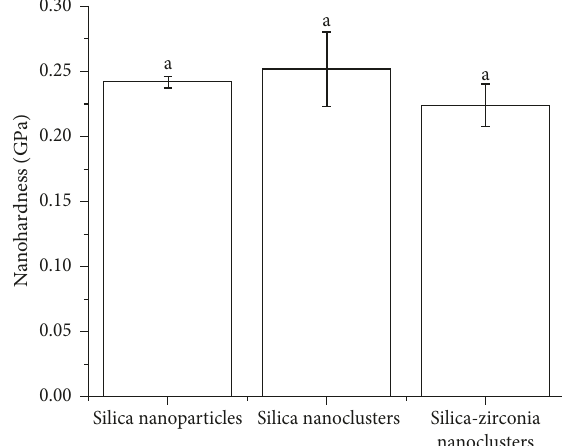
Figure 9: Nanohardness of materials reinforced with 30% by weight of particles. The letters indicate statistically homogenous groups (Tukey HSD test ( p > 0 .